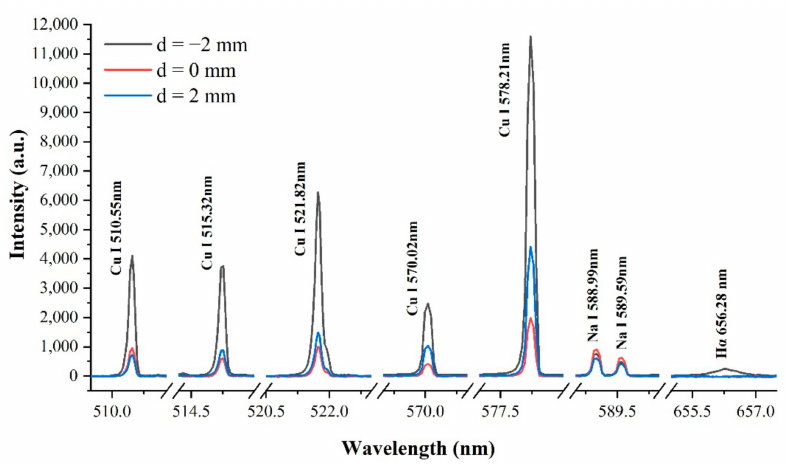
Figure 2. Copper spectra at d = − 2, 0 and 2 mm (the pulse energy is 55